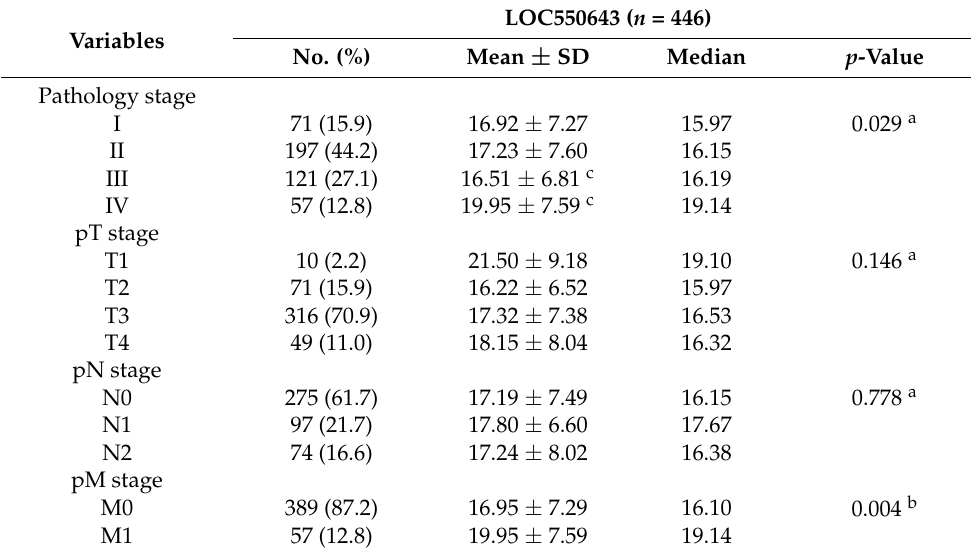
Table 1. Correlation of LOC550643 expression with clinicopathological characteristics of patients with colon cancer.